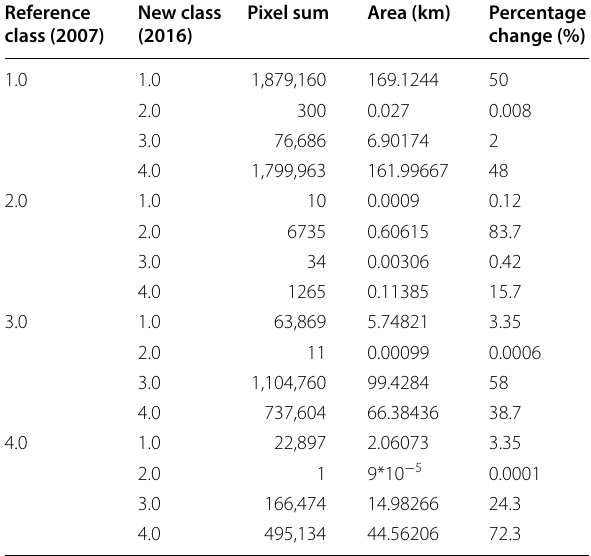
Table 1 Percentage change of the LU (1.0: trees, 2.0: dams, 3.0: bare soil, 4.0: